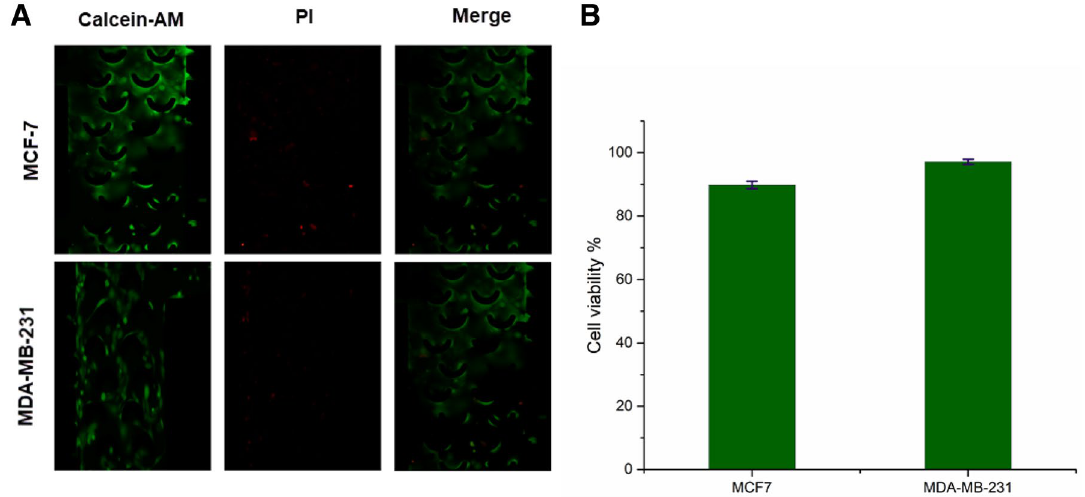
Figure 1. ( A ) Fluorescence images of live/dead assay, the green color shows the live cells and red color shows dead cells of MDA-MB-231 and MCF-7 cell lines ( B ) cell viability of the MDA-MB-231 (96.4%) and MCF-7 (91.3%), the error bar show the standard deviation (n =